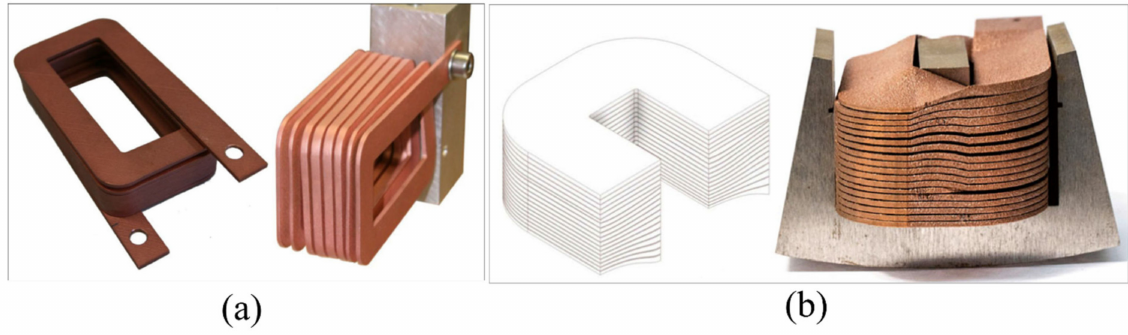
Figure 14. AM shape profiled windings. ( a ) Different thickness turns [64]; ( b ) optimized end windings [65].